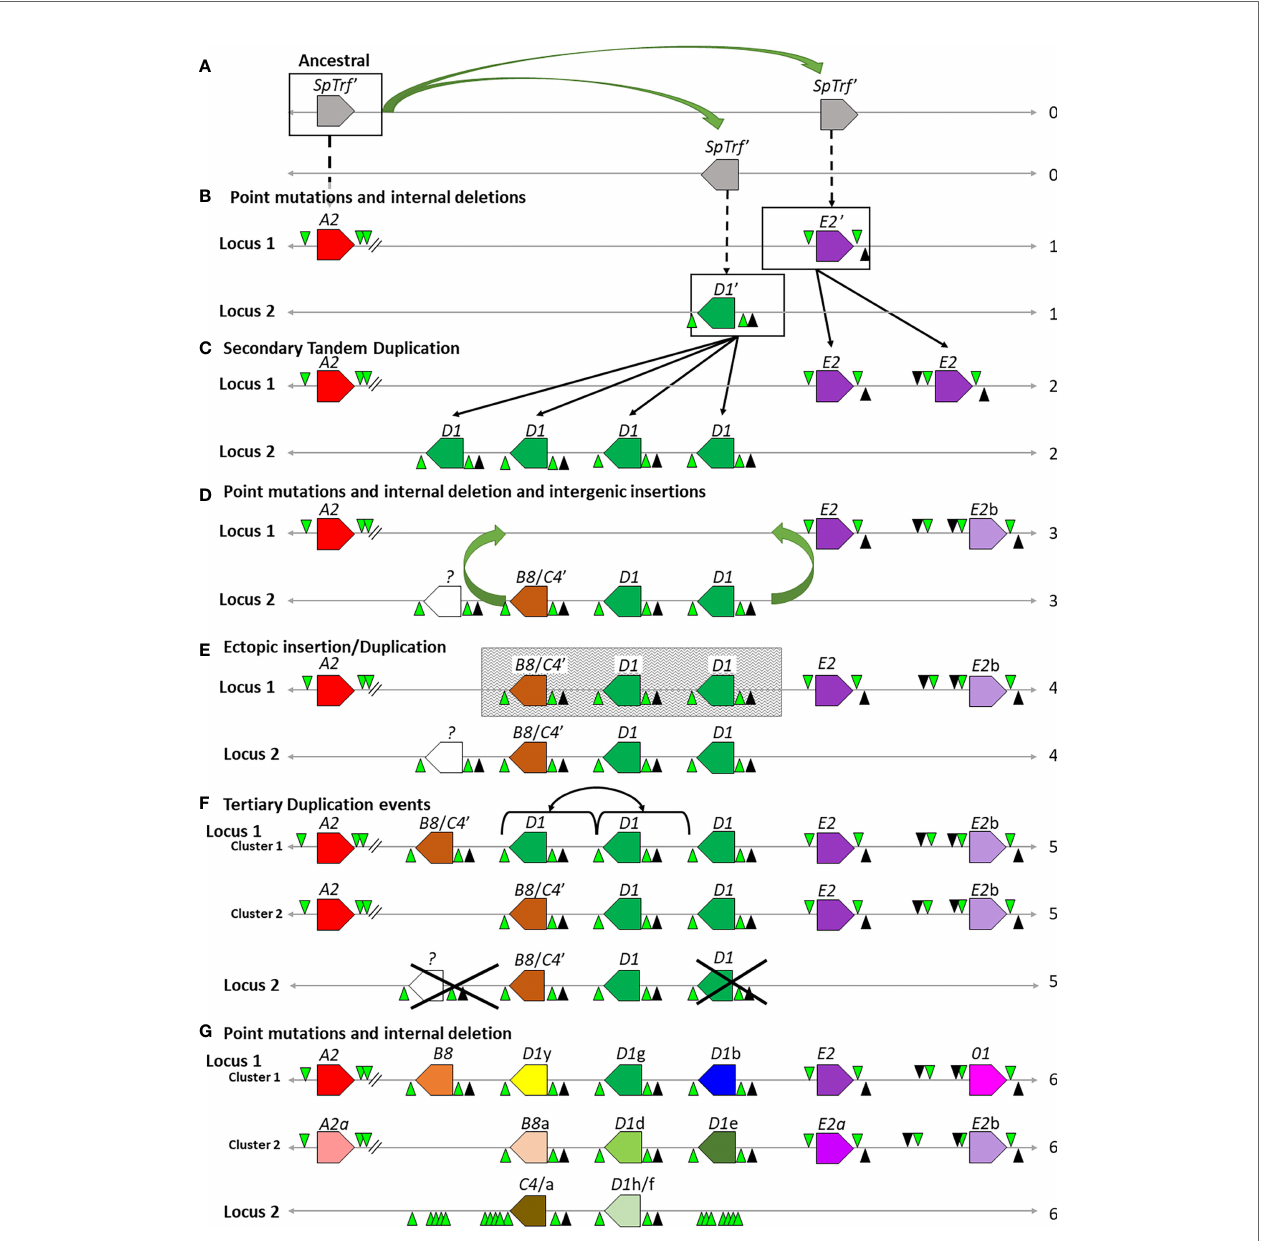
FIGURE 9 | A model for the theoretical evolutionary history of the SpTrf gene clusters in the sequenced genome based on gene duplications, ectopic insertions, and deletions. Each step in this theoretical evolutionary history of the gene clusters is indicated on the right with numbers and labeled on the left (A – G) . Genes and their direction are indicated by colored polygons and labeled with the gene name. The prime ( ʹ ) associated with a gene name indicates a hypothetical LCA version of the gene. Gene polygons without color indicate genes that are proposed to exist but whose element pattern cannot be determined. Variations in or changes to gene colors indicate internal point mutations/insertions/deletions during the lineage of a particular gene. GA (green triangles) and GAT (black triangles) STRs are shown. The horizontal gray line indicates the IGRs that fl ank the genes. Open boxes surrounding the genes in (A, B) indicate edges of proposed duplication regions. Curved green arrows indicate duplications and ectopic insertions, dotted black arrows indicated the transition from an ancestral SpTrf gene to speci fi c SpTrf gene lineages, straight black arrows indicate duplications of genes over time. The shaded box shows the ectopically inserted region in Locus 1. Brackets connected with double ended arrows indicate a recent duplication event. Large black Xs indicate gene deletions. This fi gure is not drawn to